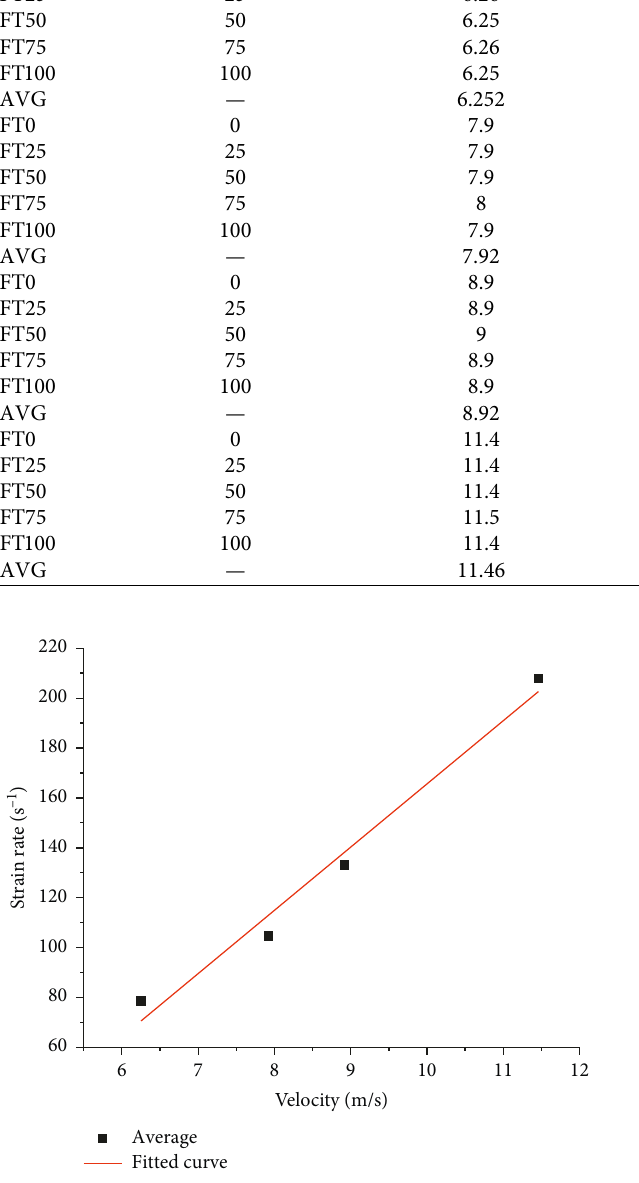
Figure 9: The relationship between bullet speed and strain rate.